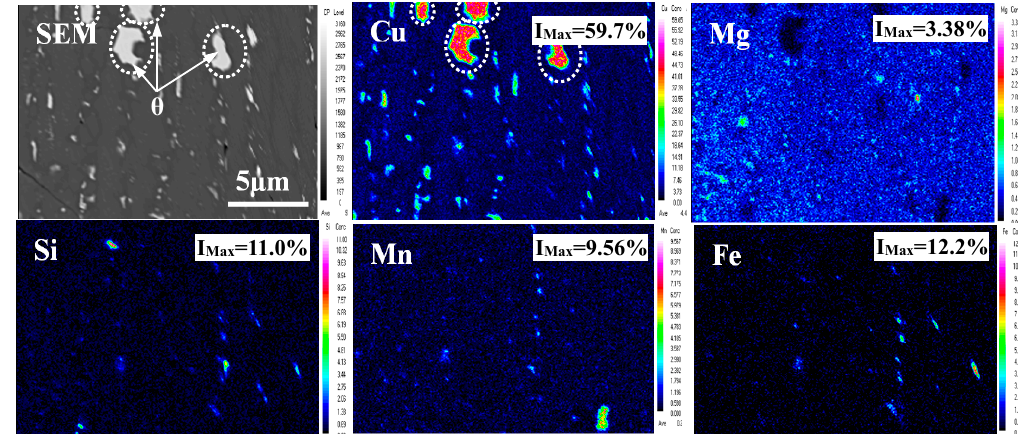
Figure 7. Elemental mapping of the as-extruded Alloy 4 examined by EPMA.